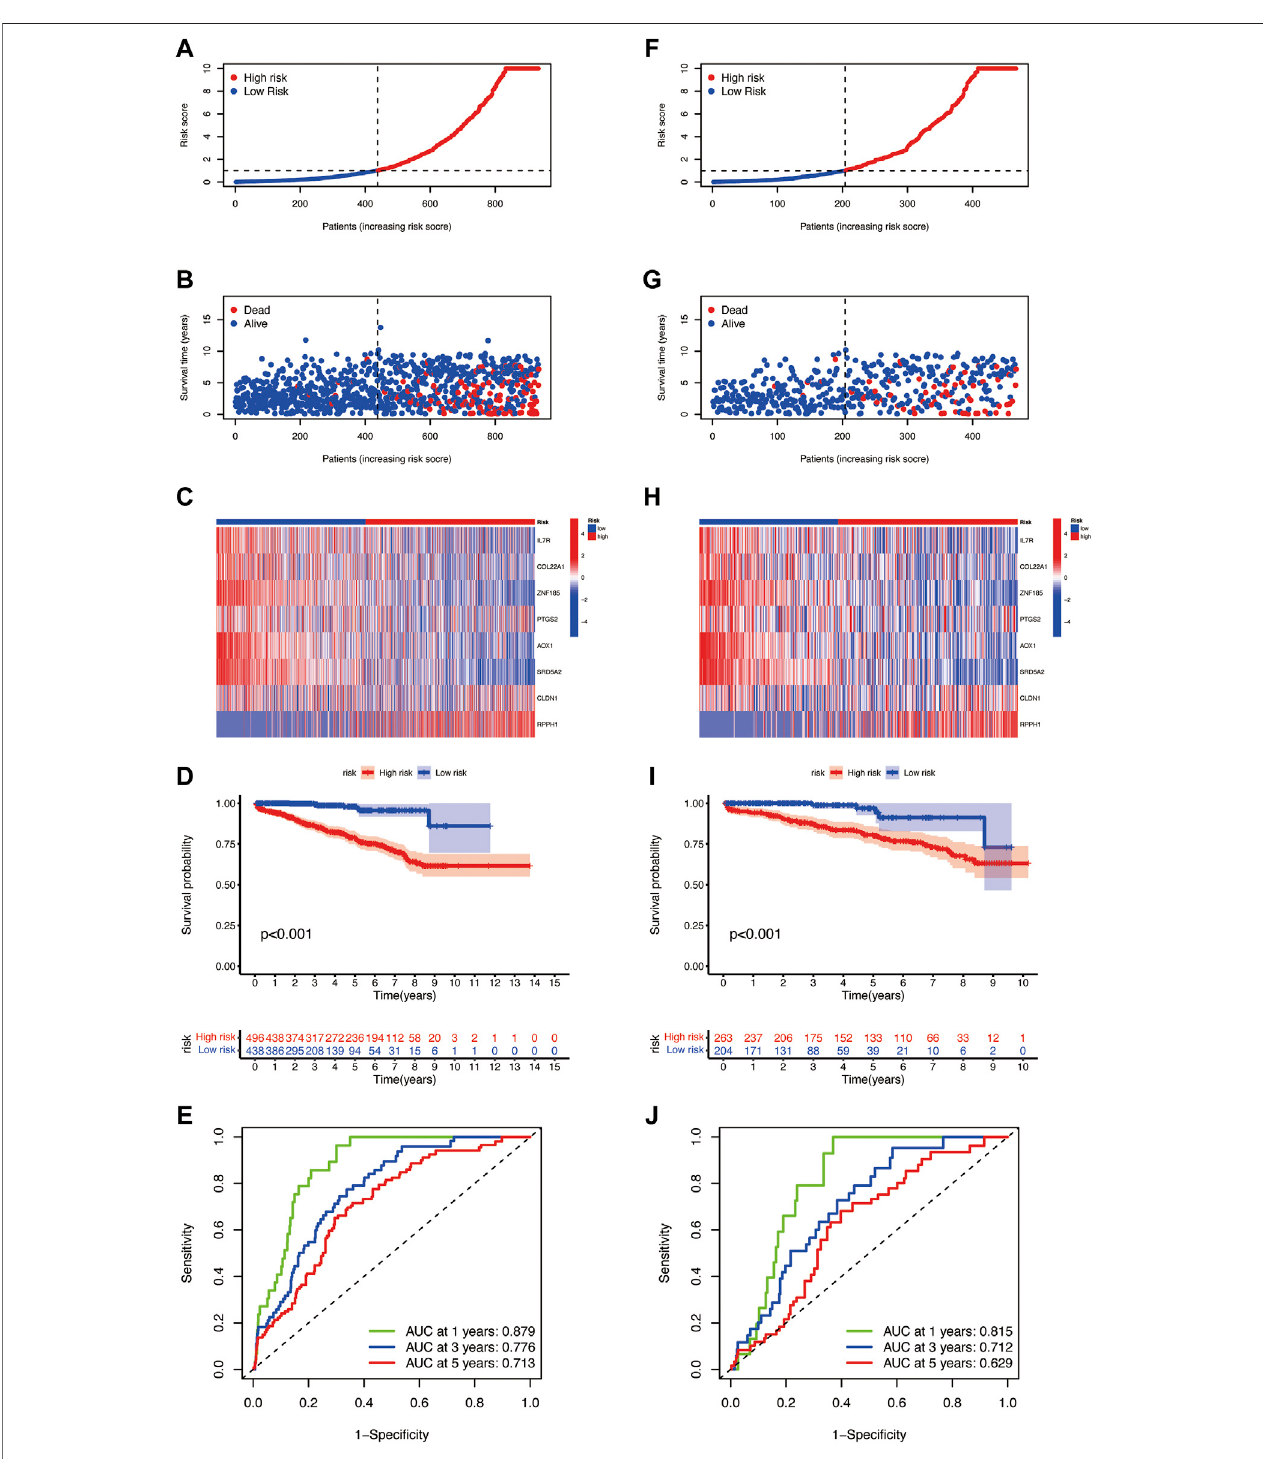
FIGURE 6 | Risk plots, the risk heatmap, the BCR incidence plot, and the 1-, 3-, and 5-year BCR rates of different risk score groups in the (A – E) entire cohort and (F – J) the testing set.